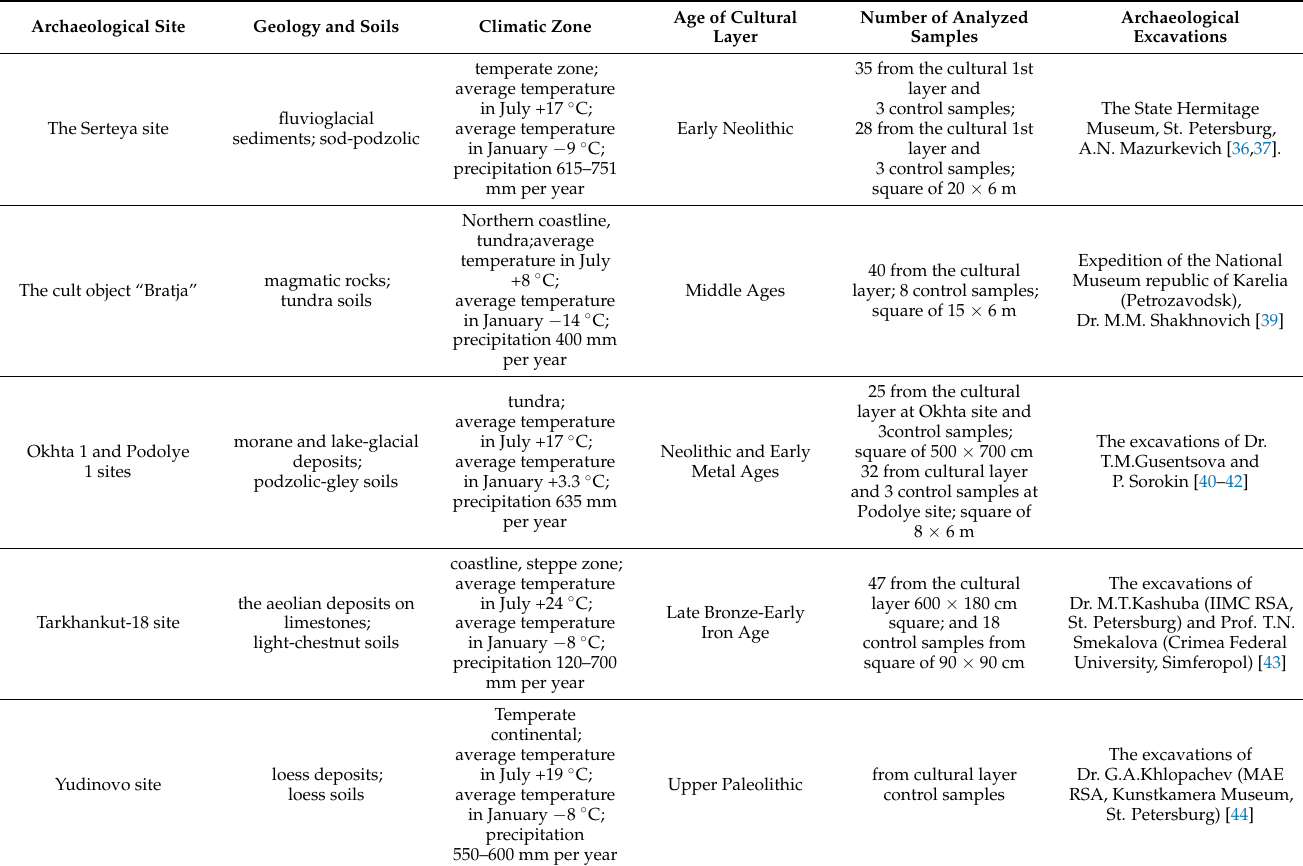
Table 1. The main characteristics of places of